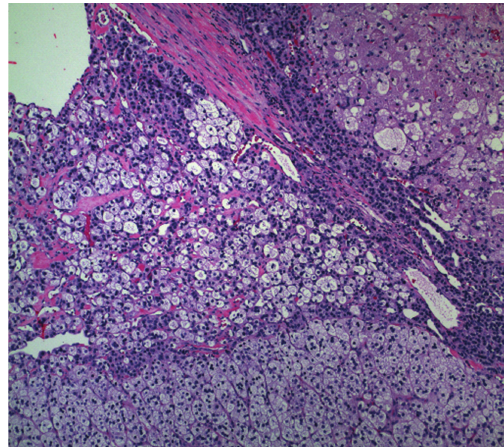
Figure 2: Adrenal cortical adenoma with areas of focal